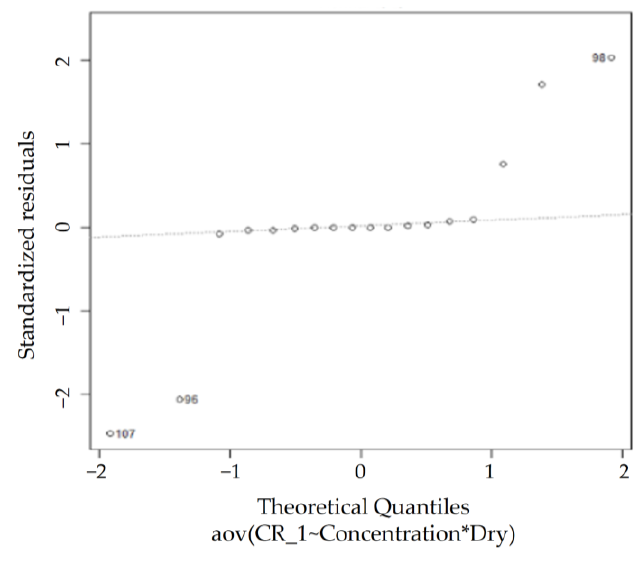
Figure 20. KL normal QQ